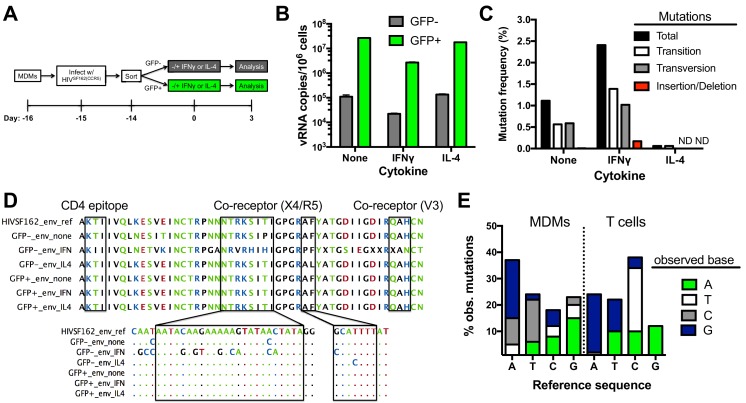
Impact of uracilation and cytokines on viral DNA and RNA sequences.(A) Experimental protocol. (B) Quantitative reverse transcriptase-PCR (qRT-PCR) was used to determine the copy numbers of extracellular viral RNA in cell supernatants from sorted GFP+ (green bars) and GFP− (white bars) MDMs with and without cytokine stimulation. Number of experimental replicates (n = 4) and errors are reported as mean ± SD. (C) Summary of mutations from limiting–dilution clonal sequencing of extracellular viral RNAs obtained from infected GFP− MDMs under different growth conditions. The mutation frequencies (point mutations per total nucleotides sequenced) were obtained from a ~500 bp amplicon of the env gene. ND; not detected. (D) Representative env sequences of extracellular viral RNAs produced by GFP− sorted MDMs. The top sequence is for the HIVSF162(CCR5) strain used to infect the MDMs (HIVSF162_env_ref). Boxed regions at the protein and nucleotide sequence level show the mutation spectrum within the CD4-associated and co-receptor binding sites. (E) Breakdown of point mutations for viral RNA produced from infected MDMs and proviral DNA from infected T cells (see text).DOI:
http://dx.doi.org/10.7554/eLife.18447.01710.7554/eLife.18447.018Figure 5—source data 1.qPCR measurement of gag copies (Figure 6B), provirus copies (Figure 6C) and uracil content (Figure 6D) in GFP sorted and cytokine-treated MDMs.Measurement of virus output, p24 (Figure 6E). Provirus content was evaluated by Ex-ALU-gag qPCR in MDM (Figure 6F) producer cells and CEMx174 (Figure 6G) target cells.